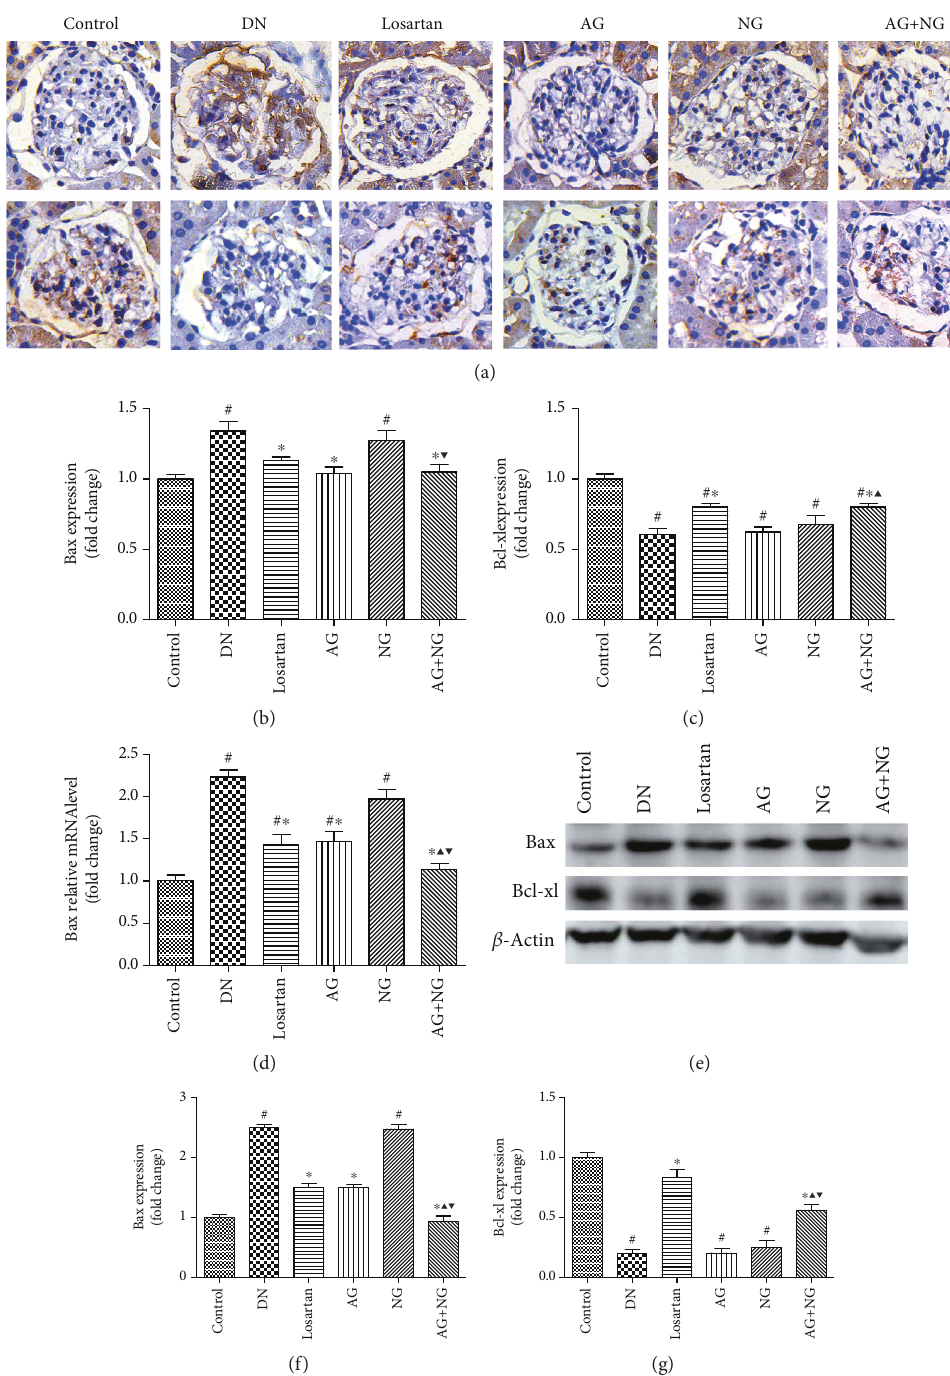
Figure 6: E ff ects of AG and NG on the expression of Bax and Bcl-xl in diabetic rats. Representative photomicrographs of immunostaining (a) and western blots (e) for Bax and Bcl-xl in the glomeruli of kidney sections. Semiquantitative analyses of immunostaining for Bax (b) and Bcl- xl (c). Glomerular relative mRNA levels of Bax (d). Semiquantitative analyses of western blots for Bax (f) and Bcl-xl (g). Control: normal control rats; DN: STZ-induced diabetic rats; losartan: DN rats treated with losartan; AG: DN rats treated with Astragalus membranaceus; NG: DN rats treated with Panax notoginseng; AG+NG: DN rats treated with Astragalus membranaceus plus Panax notoginseng. Results were expressed as the mean ± SD . # P < 0 05 vs. control group, ∗ P < 0 05 vs. DN group, ▲ P < 0 05 vs. AG group, ▼ P < 0 05 vs. NG